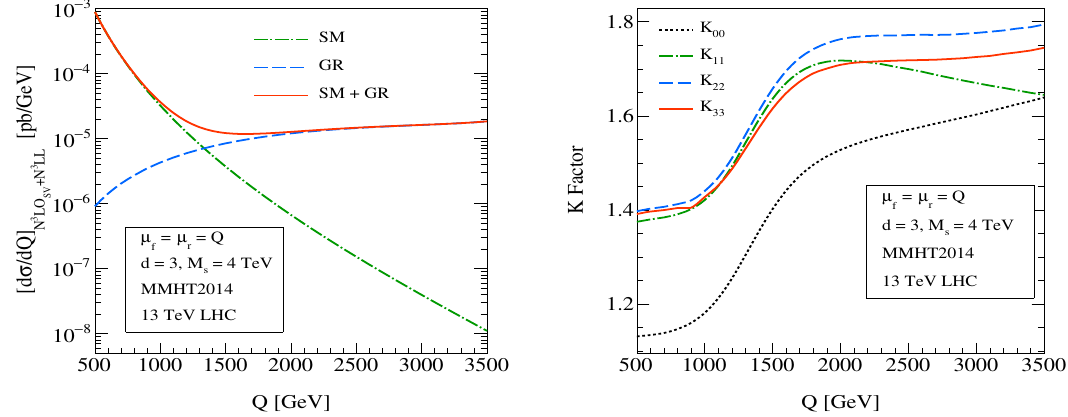
Figure 10 . Left: invariant mass distribution of di-lepton pair for ADD (GR) and signal (SM+GR) at order N 3 LO sv +N 3 LL with corresponding background (SM). Right: K-factor of di-lepton channel for signal up to order N 3 LO sv +N 3 LL with M s = 4, d =